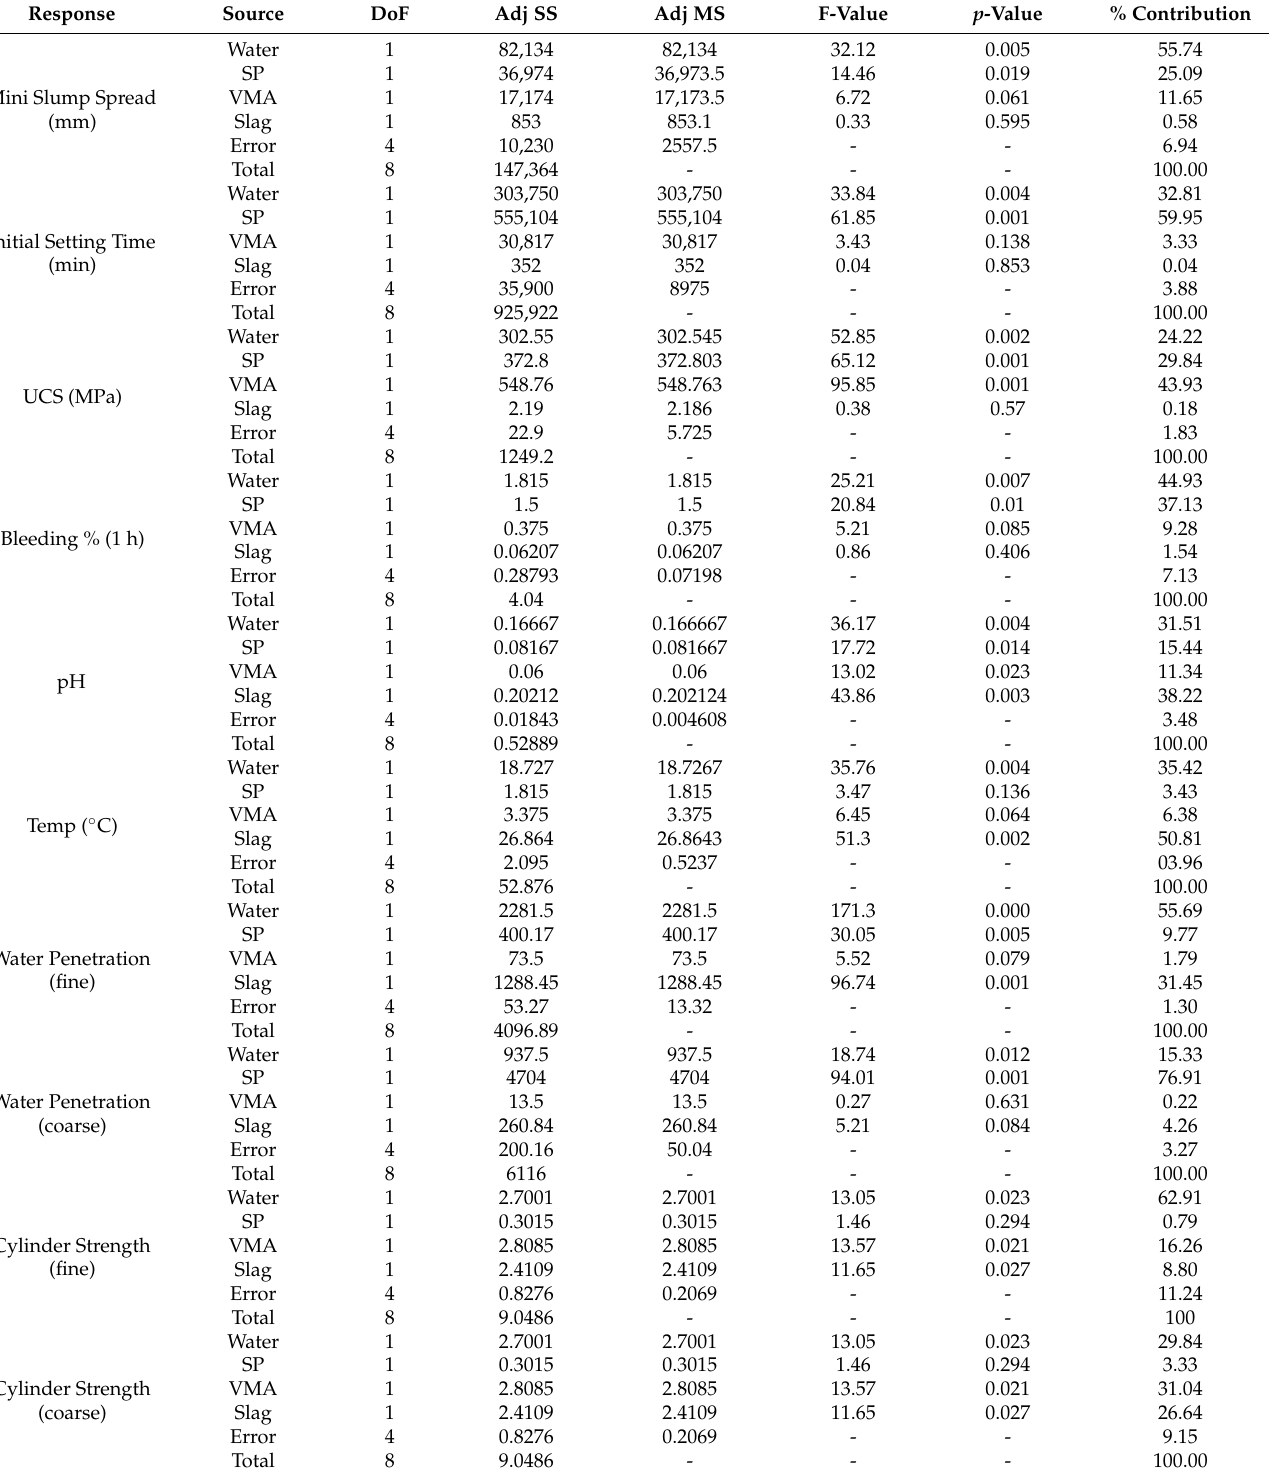
Table 7. ANOVA results for mini slump, pH, bleeding, UCS of cubes, initial setting time, and compressive strength for the cylinders of coarse and fine